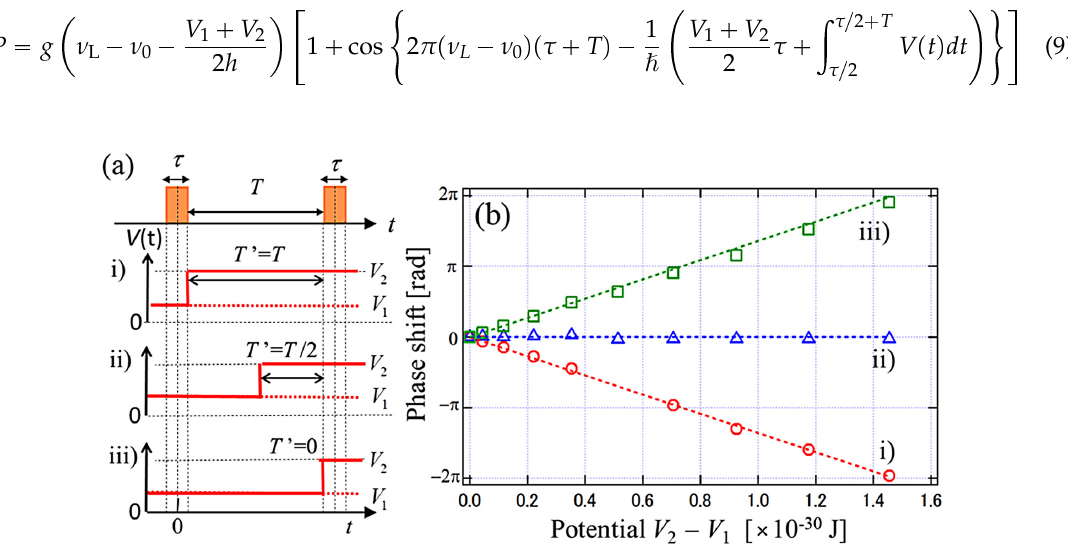
Figure 5. ( a ) Three time-varying potentials; ( b ) Phase shift on resonance for three